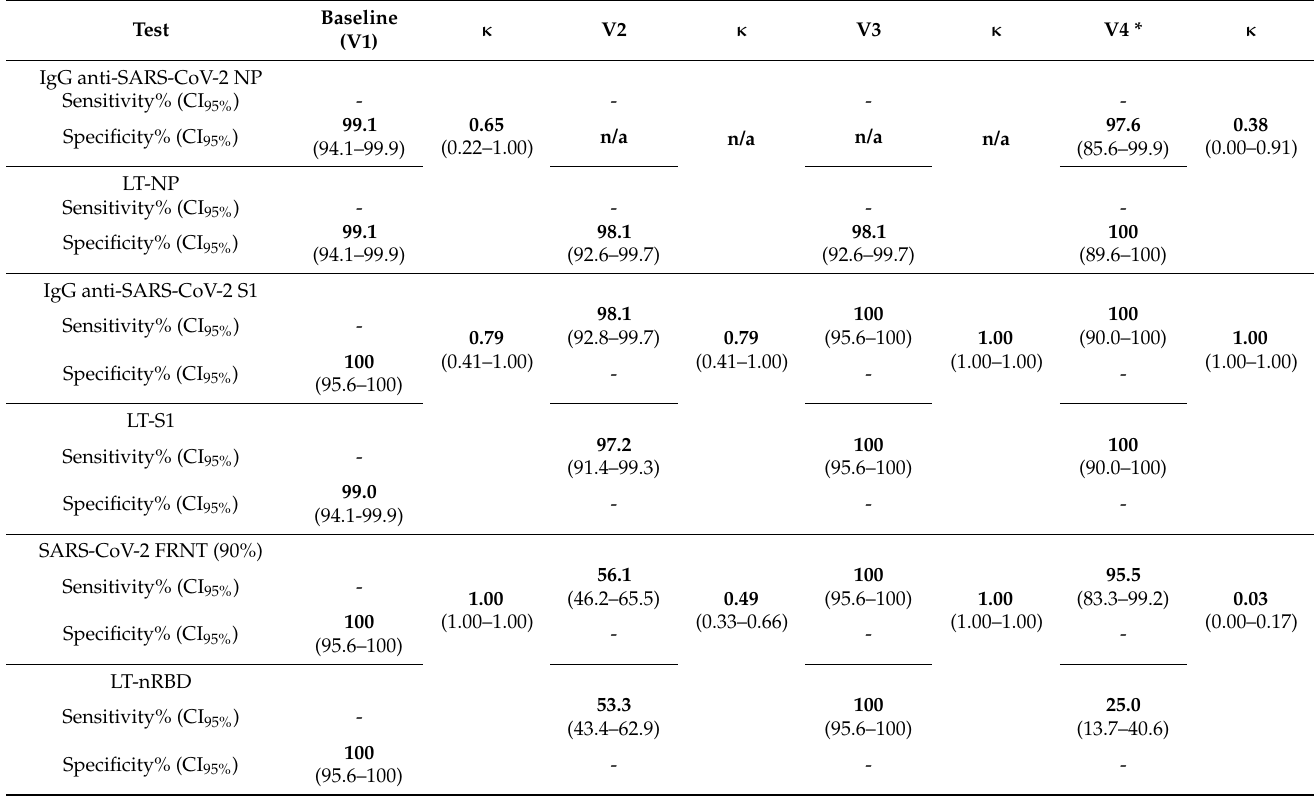
Table 1. Test performances of three different lateral flow immunoassays (LFIAs) for detection of SARS-CoV-2